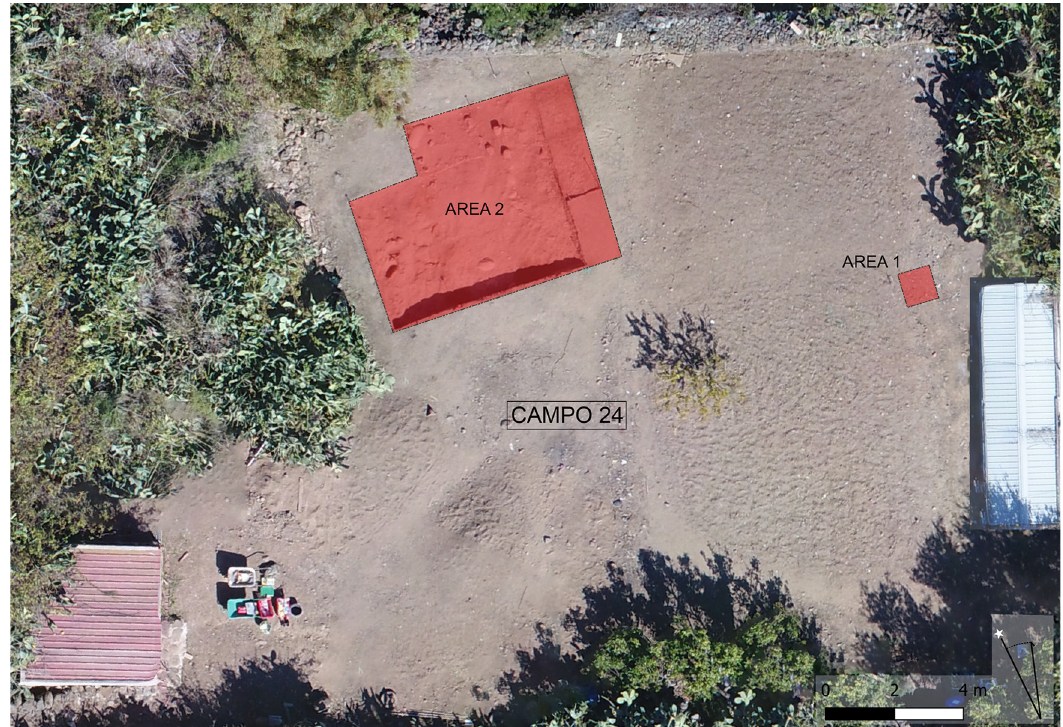
Figure 4: Position of the 2 excavation areas ( area 1, 2017 and area 2, 2018 – 2019 )